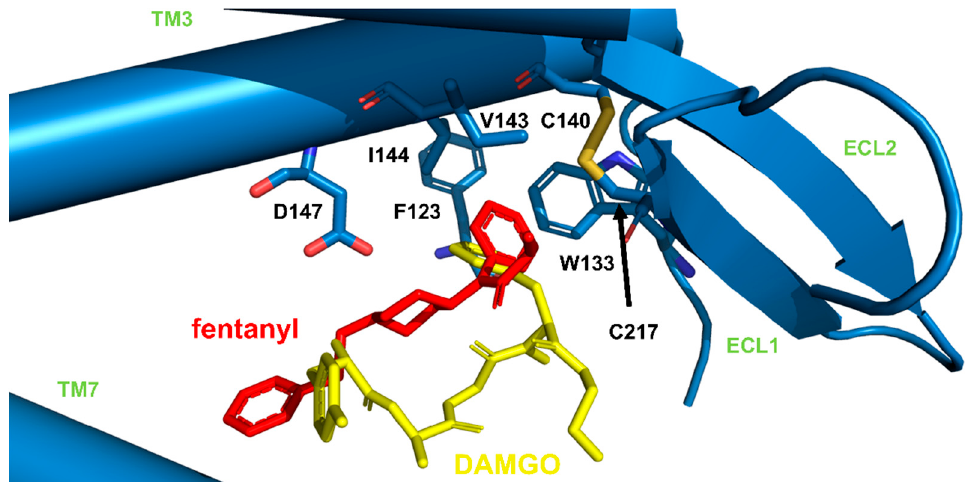
Figure 6. Imposition of fentanyl (red, our simulations) and DAMGO (yellow, PDB structure: 6DDF [53])